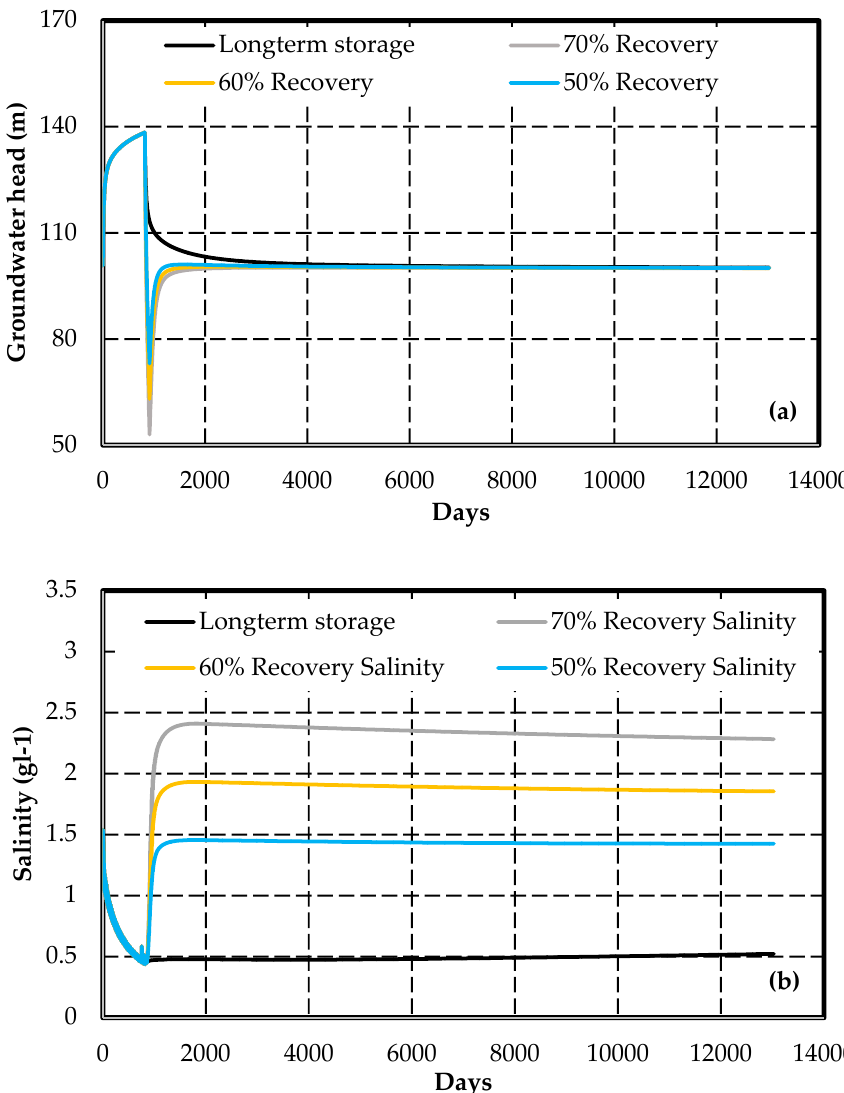
Figure 8. Numerical results at various rates of recovery. Fluctuation of groundwater head ( a ); concentration of salinity ( b ).